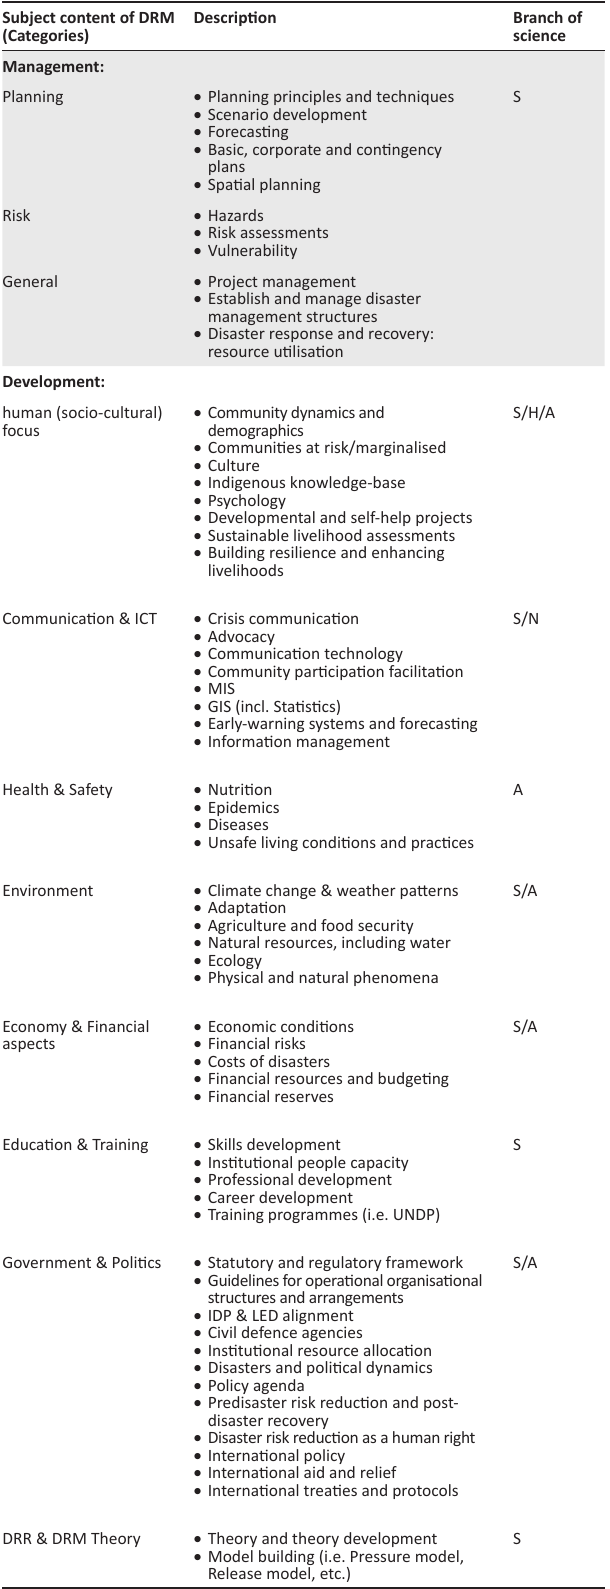
TABLE 4: Content analysis of formal and non-formal qualifications and programmes. TABLE 5: Research results.